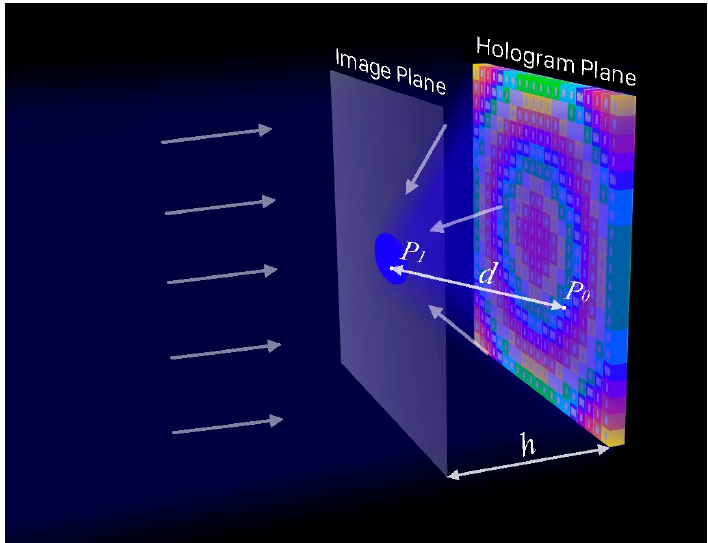
Figure 1. Scheme of the acoustic focusing with a hologram. A series of acoustic waves are incident onto the hologram plane vertically and reflected to focus on the image plane, which is parallel to the hologram plane. The different colors represent the different reflection phases for the incident acoustic wave.